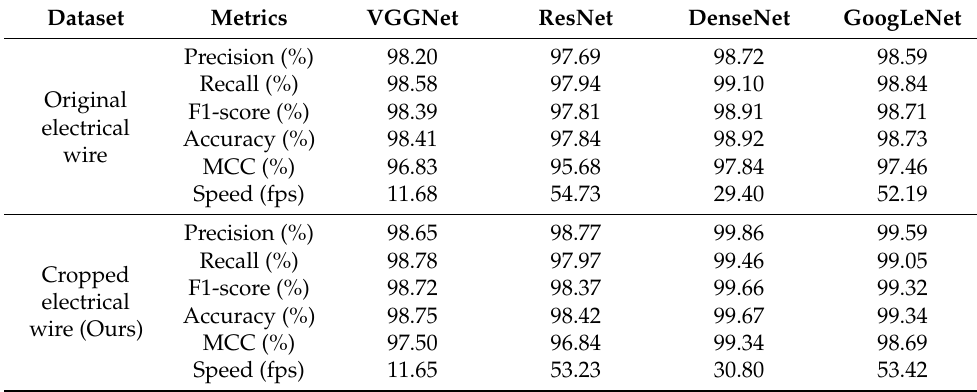
Table 5. The average performance while using the two electrical wire datasets.